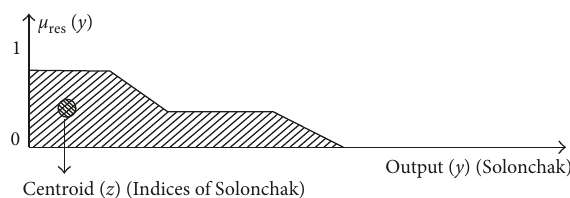
Figure 5: A method of the centroid used for